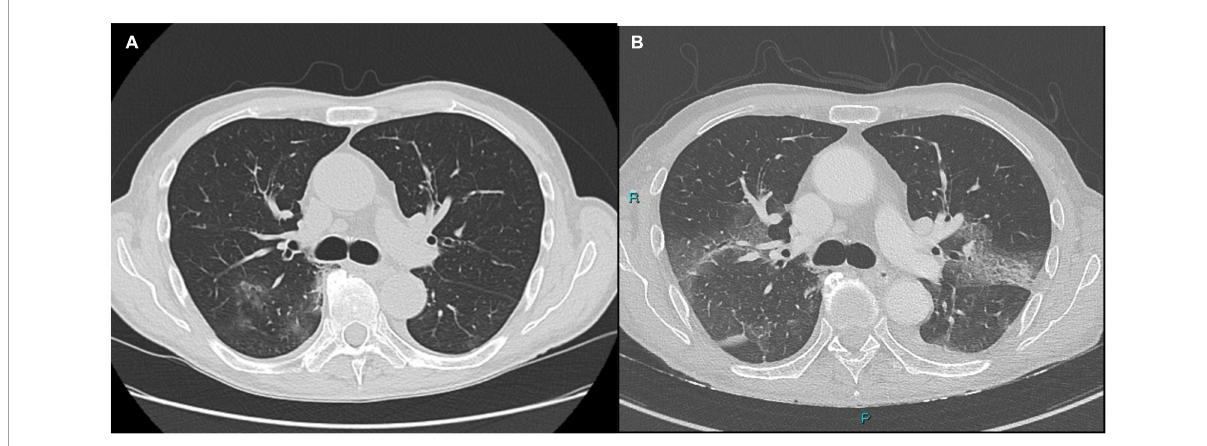
FIGURE2 (A) Interstitial pneumonia with peripheral small nodules. Postero-basal and para-scissural opacities. (B) Ground-glass opacities at the bases of the upper lobes dorsally, with partial periscissural consolidative area. Moderate bilateral pleural effusion with associated disventilatory